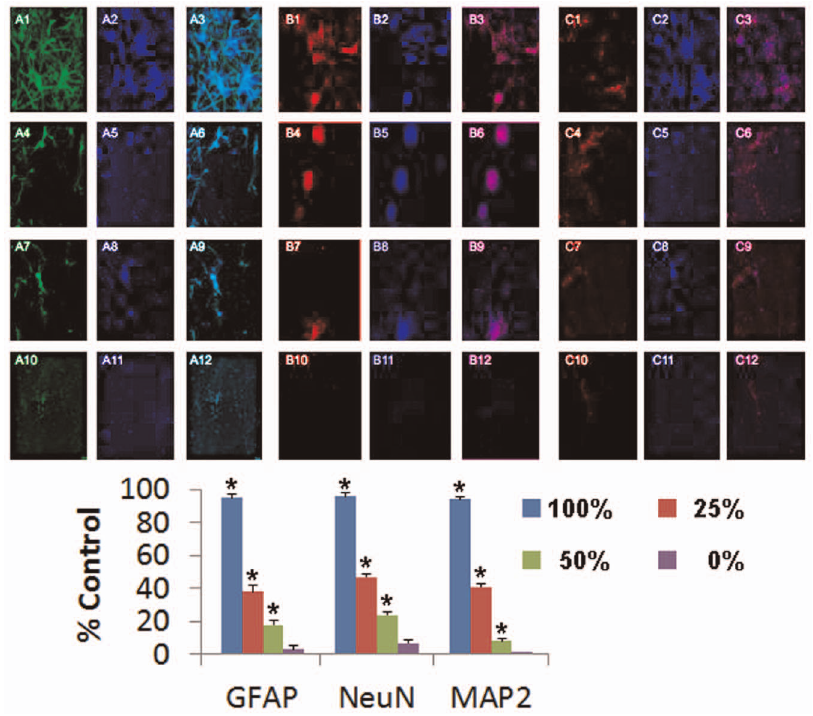
Figure 4. DPCs dose-dependently facilitate GFAP, NeuN, and MAP2 expression in primary rat cells post-OGD. Immunocytochemical analyses revealed that co-culture of DPCs modulated dose-dependent expression of GFAP, NeuN, and MAP2 in OGD-exposed primary neural cells in the following order: 100% . 50% . 25% . 0%. Phenotypic markers labeled as A: GFAP; B: NeuN; C: MAP2; Immunofluorescence identified as 1: phenotypic marker; 2: DAPI; 3: Merged; Cell doses given as 1–3: 100%; 4–6: 50%; 7–9: 25%; 10–12: 0%. Quantitative analyses revealed dose-dependent expression of these neural markers (*p , 0.05 vs. controls).